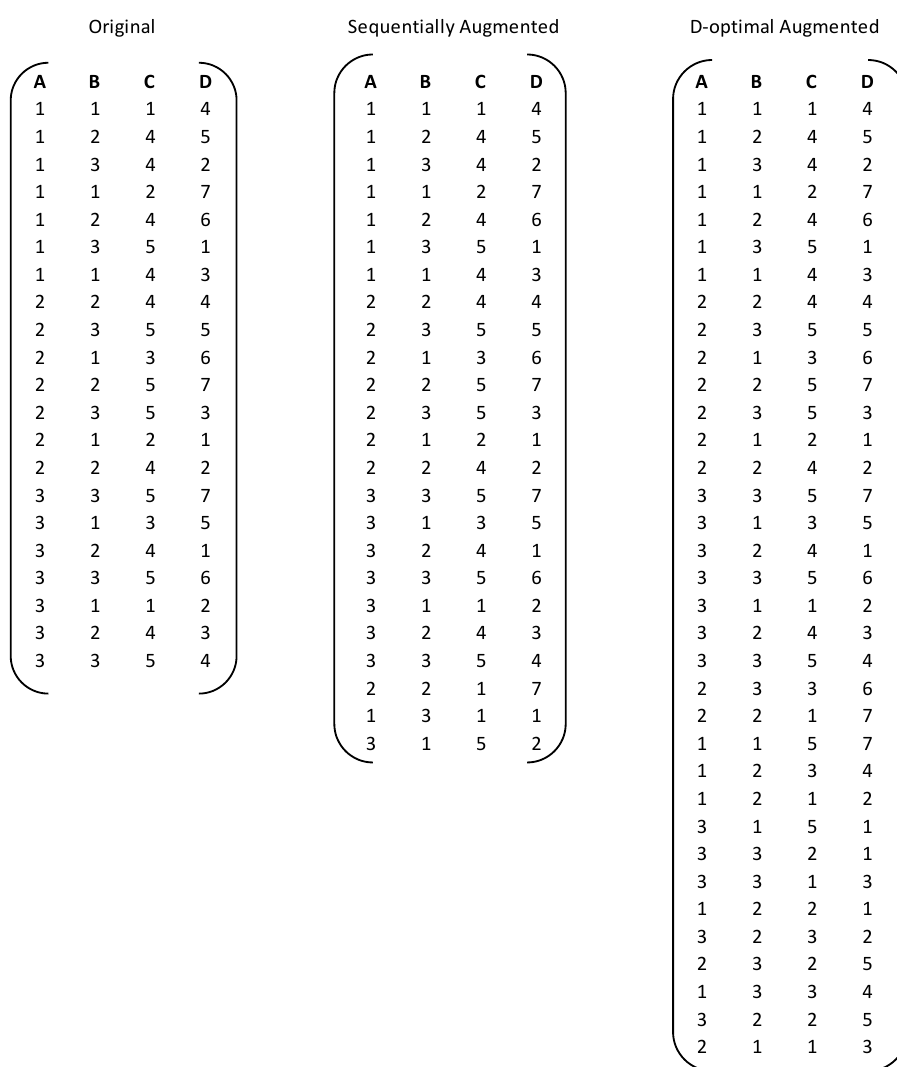
Figure 16. Alias structure for EA (21, 3 2 5 1 7 1 ).